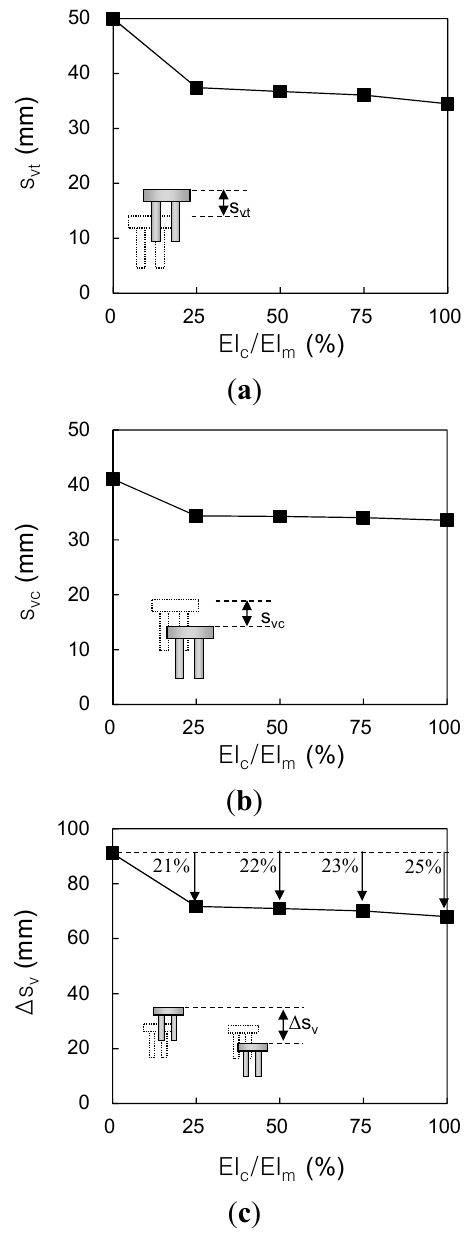
Figure 11. Reductions in vertical displacements with connection beam: ( a ) uplift displacement (s vt ); ( b ) compressive settlement (s vc ); and ( c ) differential settlement ( Δ s v